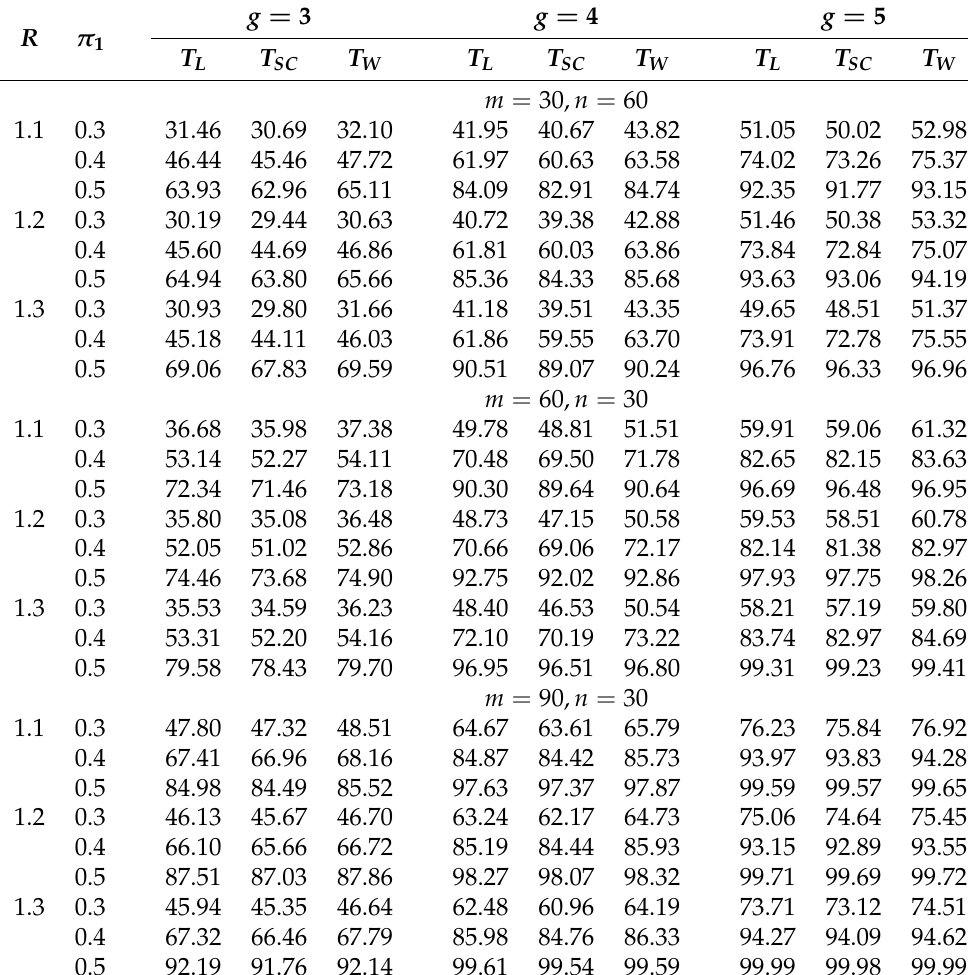
Figure 2. Empirical powers of tests. Table 7. The power (%) of the unbalance group ( α =